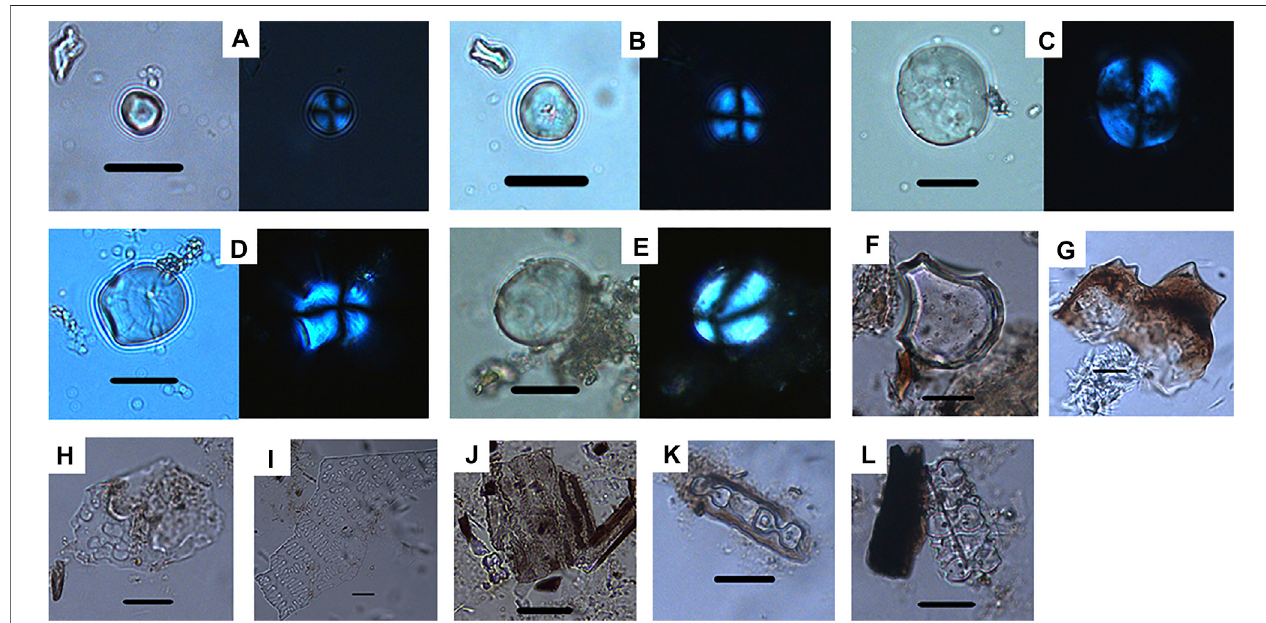
FIGURE 3 | Starch grains (A − E) and phytoliths (F − L) recovered from the residues on the grooved vessels from the Meishan Site. Each starch grain is shown in bright fi eld and polarized views. (A,B) Foxtail millet or broomcorn millets; (C) Triticeae; (D) geophytes; (E) possibly Chinese yam; (F) rice bulliform phytoliths from rice leaves with increased scale numbers; (G) double-peaked phytolith from rice husk; (H) Ω -type phytolith from foxtail millet husk; (I) η -type phytolith from broomcorn millet husk; (J) dendritic epidermal phytolith possibly from wheat or barley glumes; (K) bilobate-scooped phytolith from Oryzoideae; and (L) bilobate-scooped phytolith from Paniceae. Scale bar, 20 μ m.